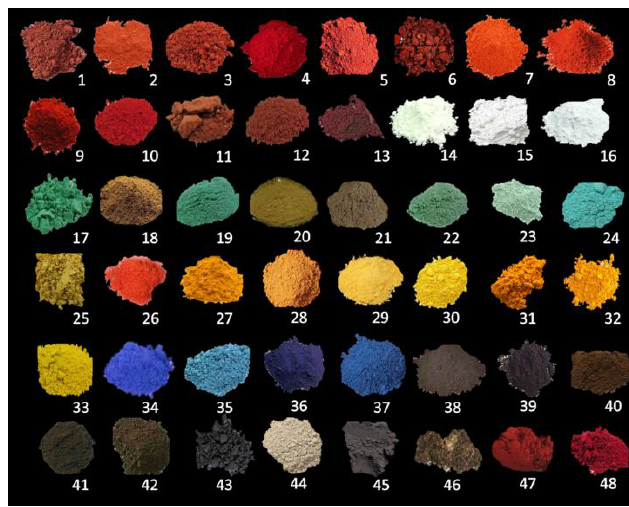
Figure 1. Set of 48 natural powdered pigments by Zecchi store collection. From 1 to 13, Red pigments: Hematite, Ercolano , Cinabrese , Carmine, Ochre, Dragon’s blood, Coral, Red Lead, Alizarin, Cinnabar, Bolo , Jasper, Morellone ; from 14 to 16, White Pigments: White Lead, San Giovanni , White Bone; from 17 to 33, Earths (green and yellow pigments): Malachite , Campeggio , Chrysocolla, Aloe, Brazilwood, Jasper, Verdaccio , Verdigris, Arzica , Saffron, Turmeric, Yellow Ochre, Giallorino , Yellow Napoli , Gommagutta , Orpiment, Stil de grain; from 34 to 37, Blue pigments: Smalt, Azurite, Indigo, Lapis lazuli; from 38 to 43, Black Lamp, Ivory, Sepia, Bitumen, Vine Black, and Graphite; from 44 to 46: Vicenza Earth, Romana Earth, and Schist. Finally, the lake pigment, Gommalacca and Garanza , 47 and 48 respectively. The natural pigments reported in Italics are pure of Italian origin (e.g., Ercolano red is obtained from iron-deposits near Ercolano , Naples).